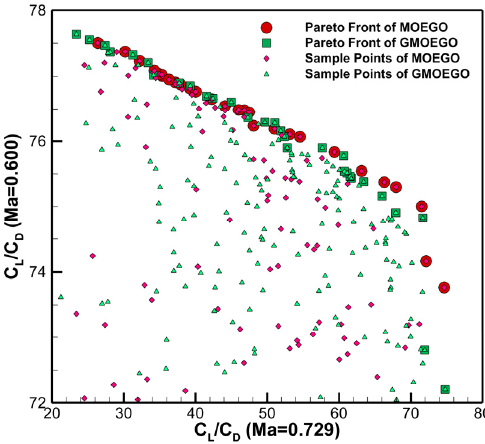
Figure 14. Obtained optimal Pareto fronts.